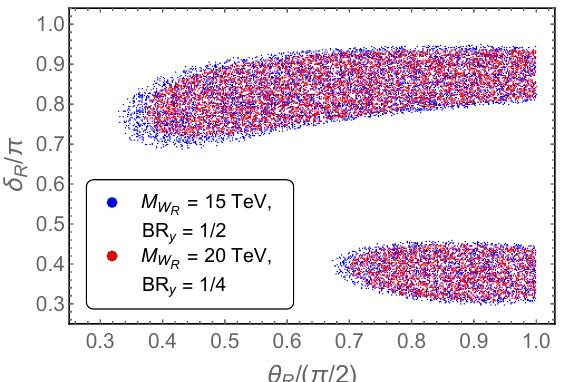
Figure 10. Scatter plot of (cid:18) R and (cid:14) R which can generate the observed baryon asymmetry, with two benchmark points of M W = 15 TeV and BR y = 1 = 2 (blue) and M W R (red). We have set the average RHN mass at 1 TeV in both